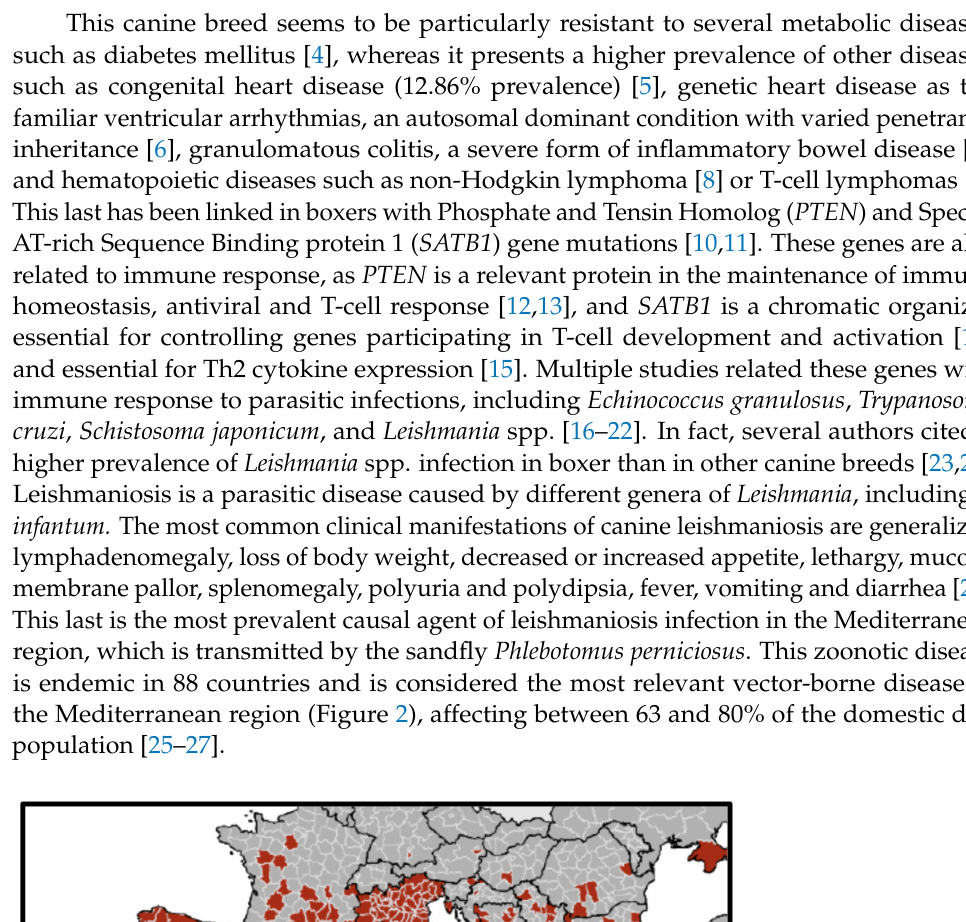
Figure 1. Photograph of adult male of boxer breed (extracted from The Kennel club materials).